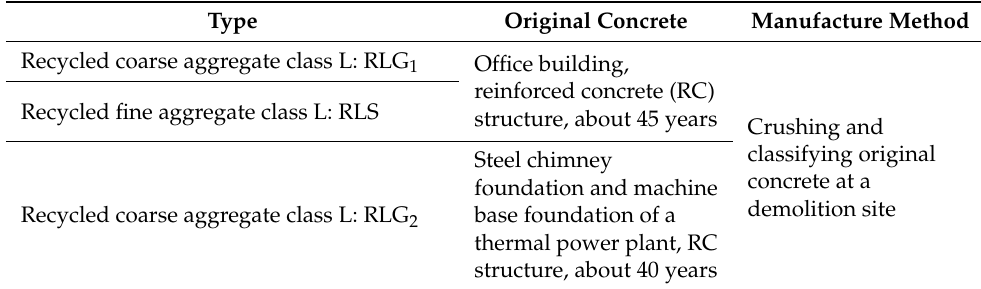
Table 4. Outline of recycled